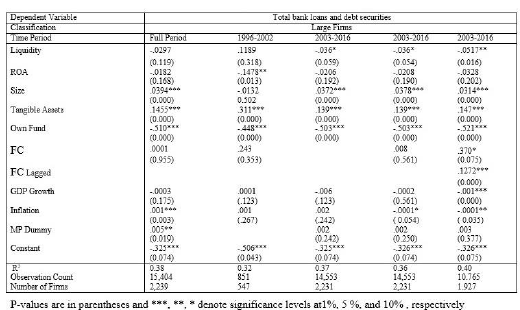
Table 3: Fixed Effect Analysis on Financial Debt-